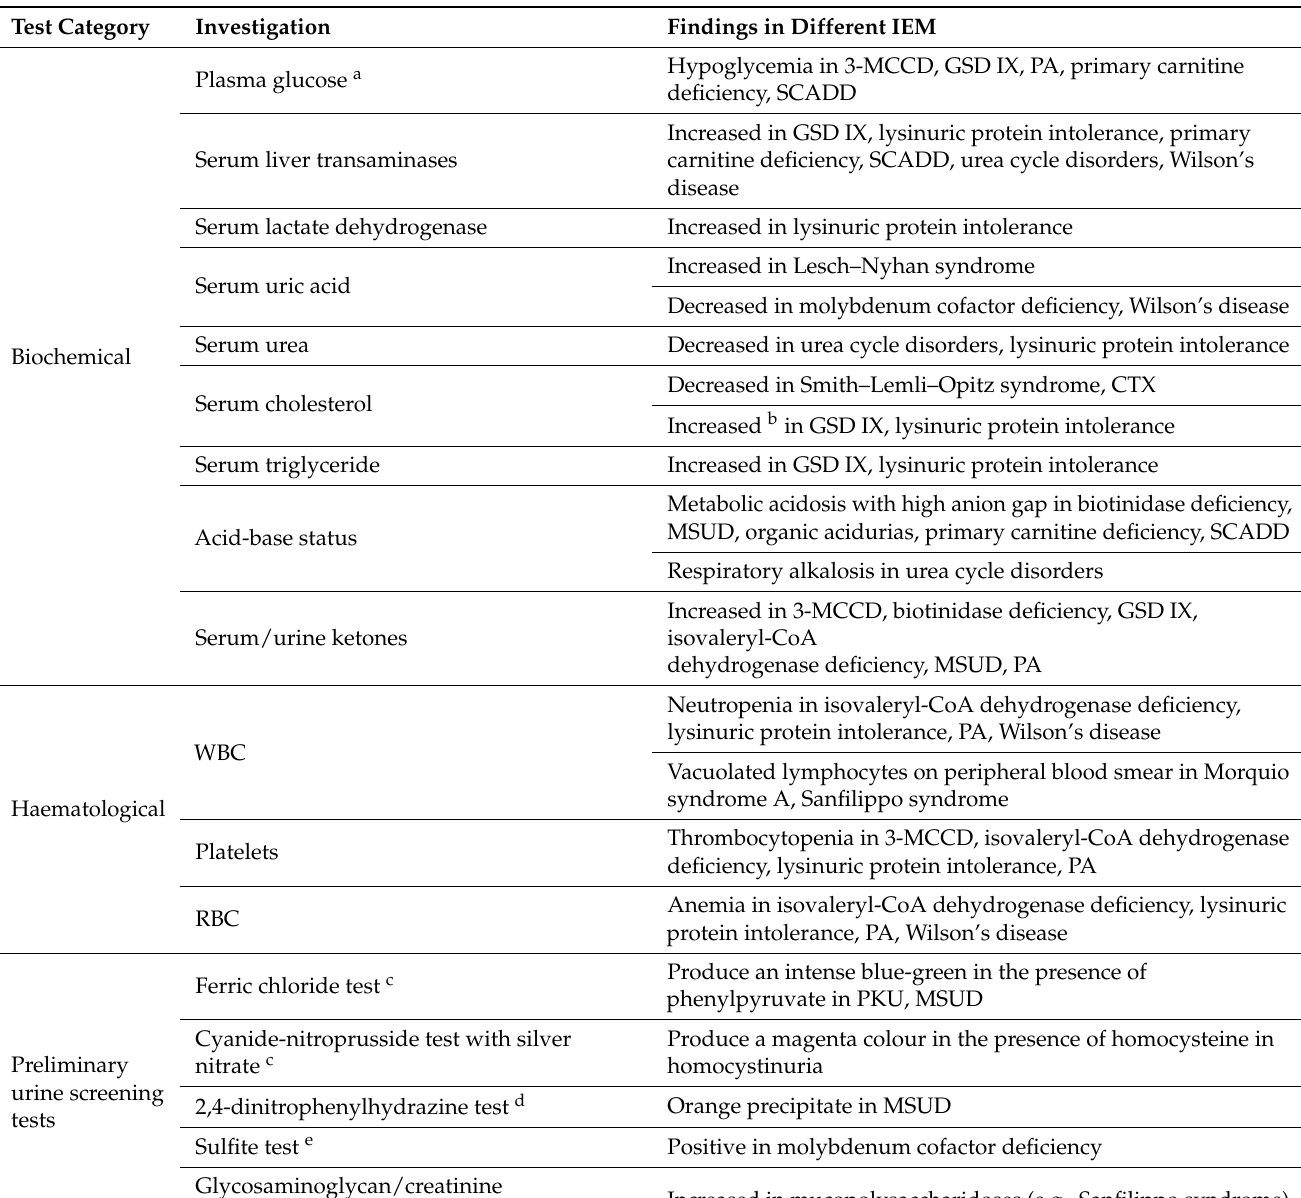
Table 2. Basic screening [100–112]. (3-MCCD: 3-methylcrotonyl-CoA carboxylase deficiency,